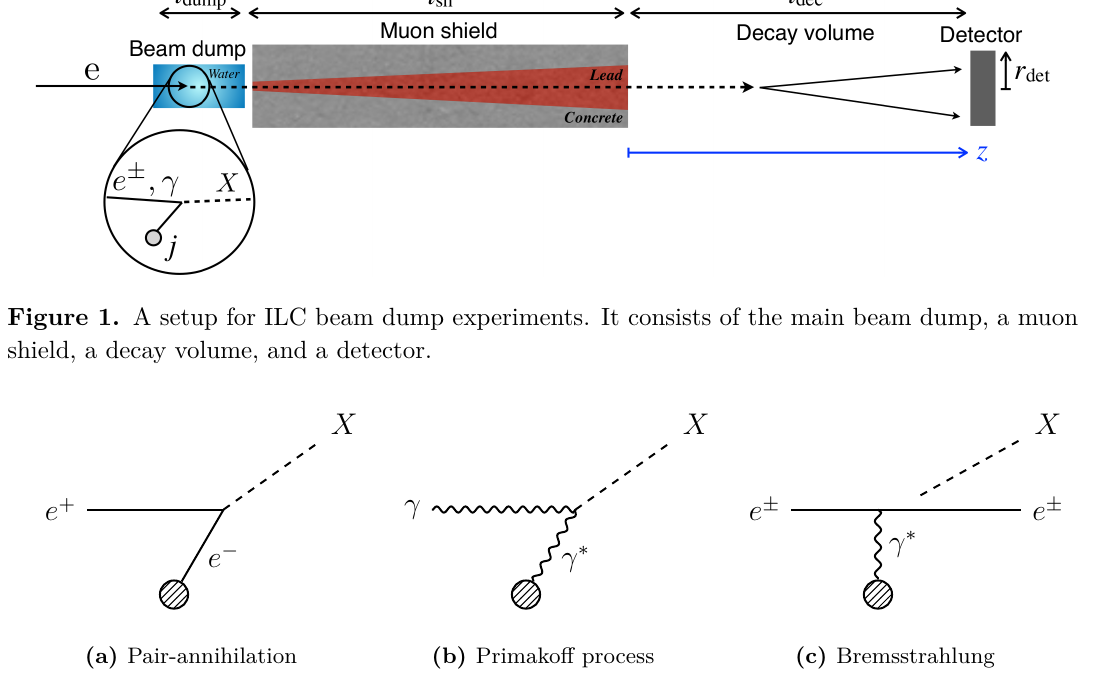
Figure 2. Three production mechanisms of a hypothetical particle X . The left-most particle in each figure comes from the electromagnetic shower or the beam itself, while the blobs illustrate the attached particles originate in water